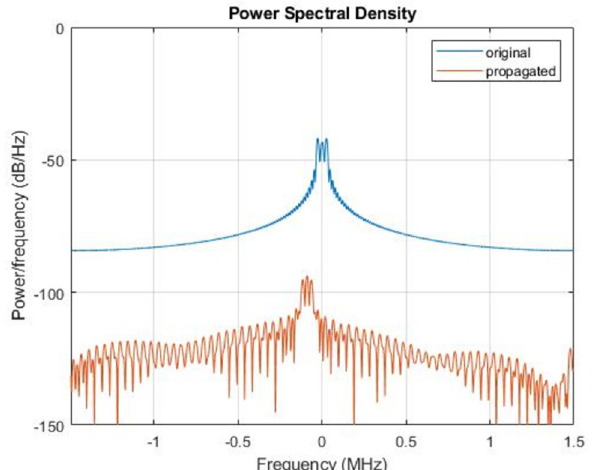
Fig 7. Plot of Wideband propagation signal for the spectrum of original signal and the Doppler-shifted signal with central frequency, 3Ghz.